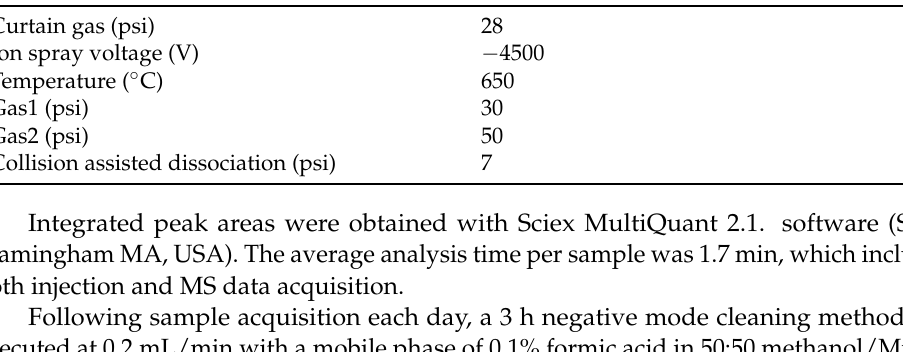
Table 2. Source dependent parameters for